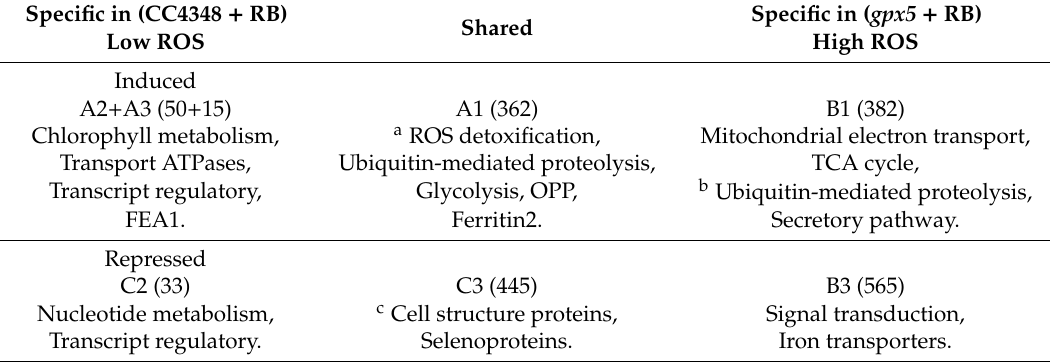
Table 1. Overview of metabolic pathways and cellular processes in each subgroup from Figure 5. The numbers in brackets represent the counts of according